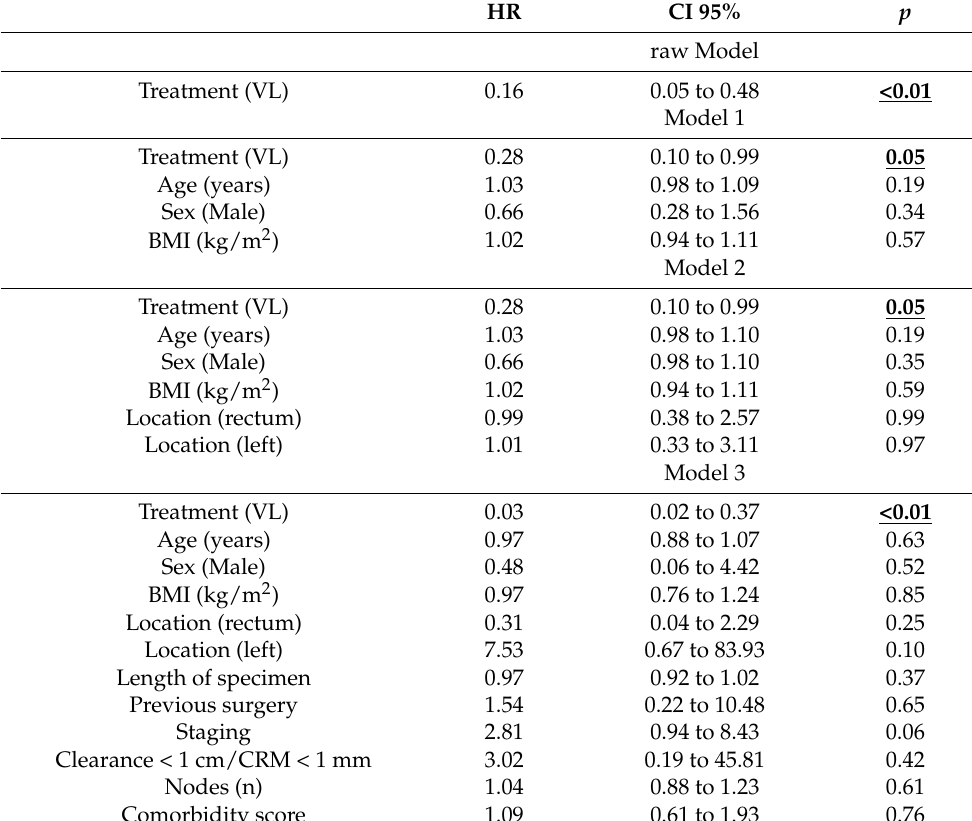
Table 3. Multivariate Cox regression analysis on overall mortality.